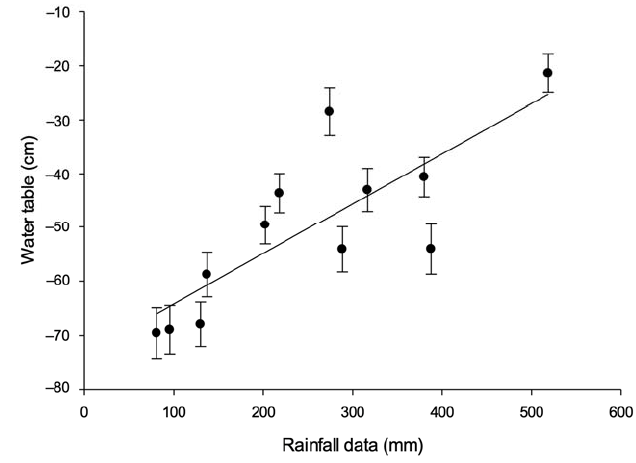
Figure 4. Water table versus monthly cumulative rainfall.